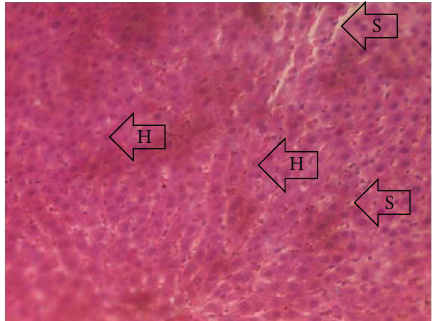
Figure 6: Photomicrographs of the group VI rats with normal liver of intact hepatocytes, sinusoids containing Kup ff er cells, and congested central